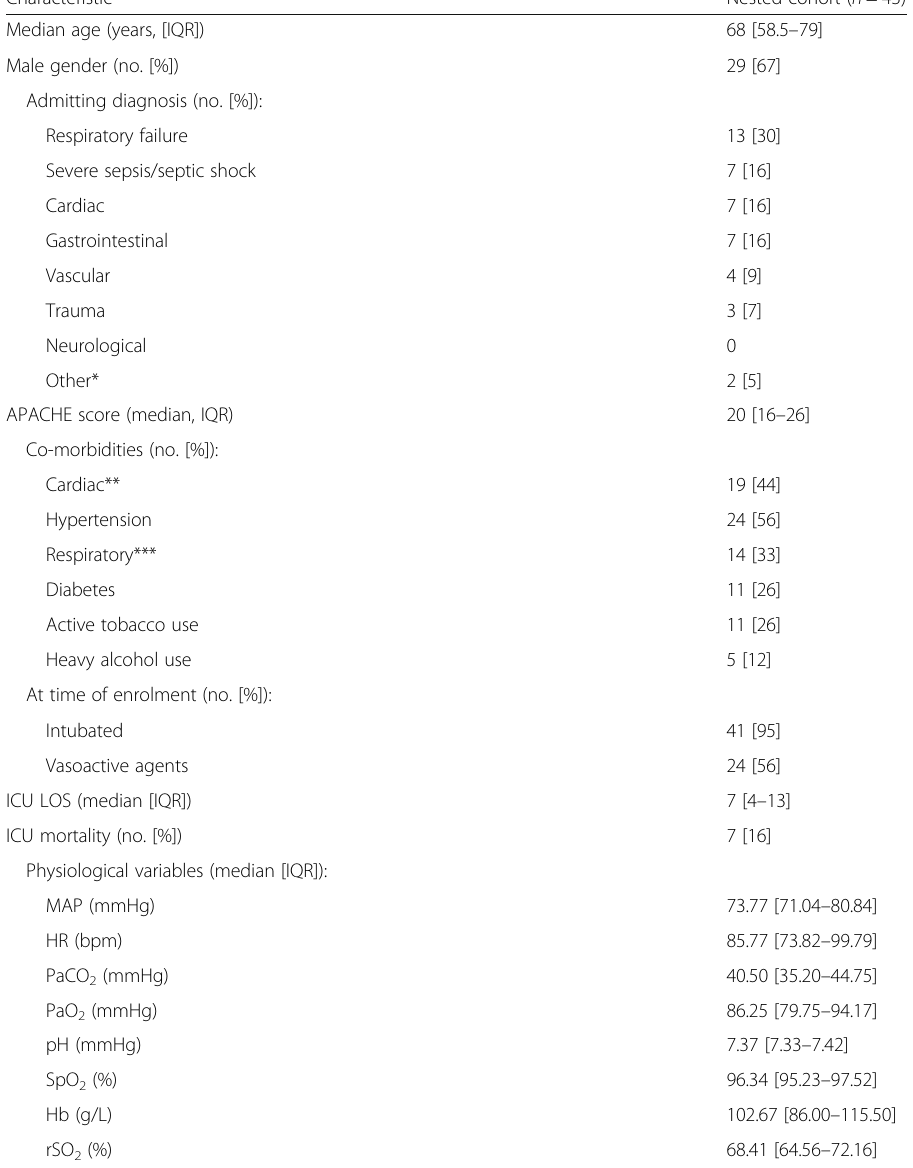
Table 1 Demographics and clinical characteristics